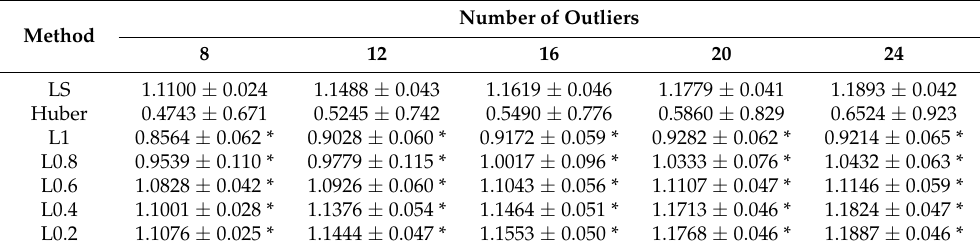
Table 3. Parameter estimation bias of the two-input–single-output (TISO) system with different numbers of